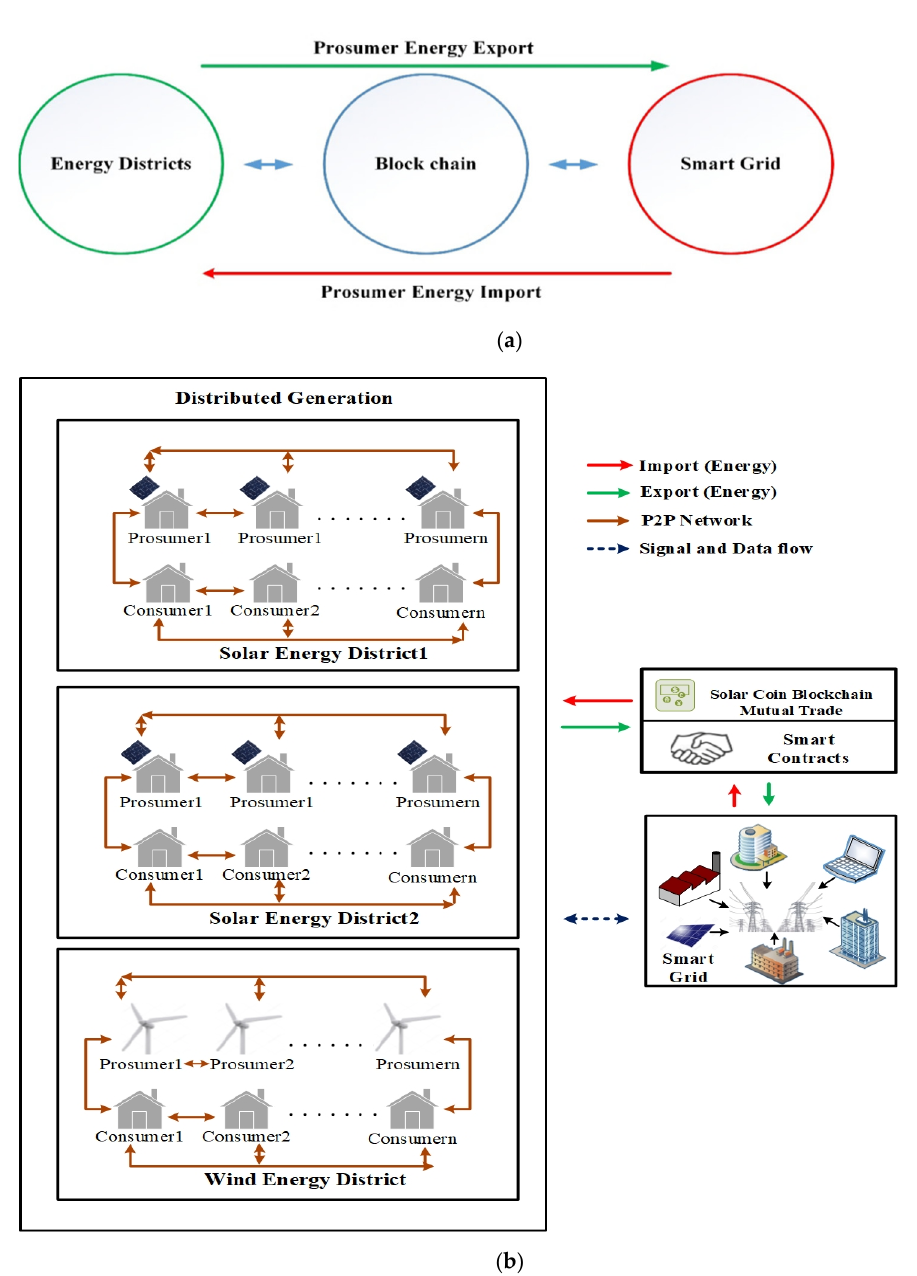
Figure 1. ( a ) Blockchain-based bi-directional METM, ( b ) SLR Blockchain-based bi-directional METM.